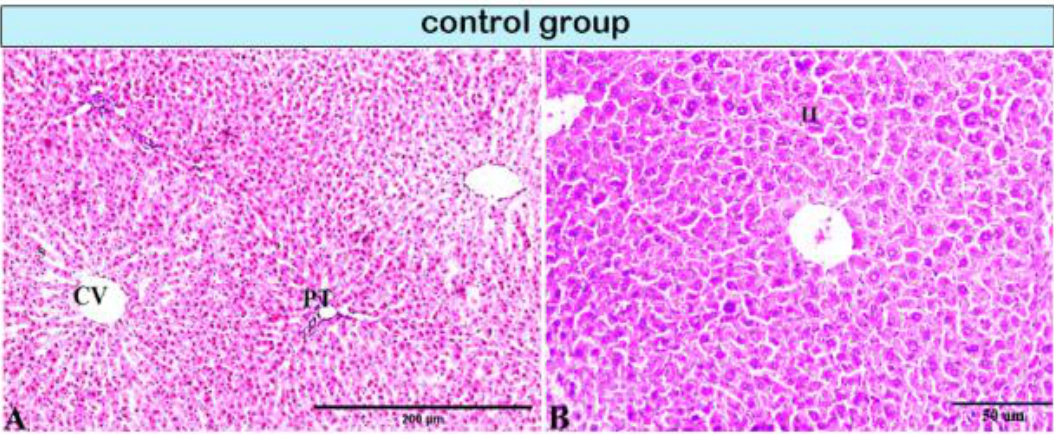
Figure 1. Photomicrograph of a rat liver in the control group demonstrating normal hepatic architectures. ( A ) Central vein (CV), sinusoids (S), and intact portal tirade (PT). ( B ) Hepatocytes (H).